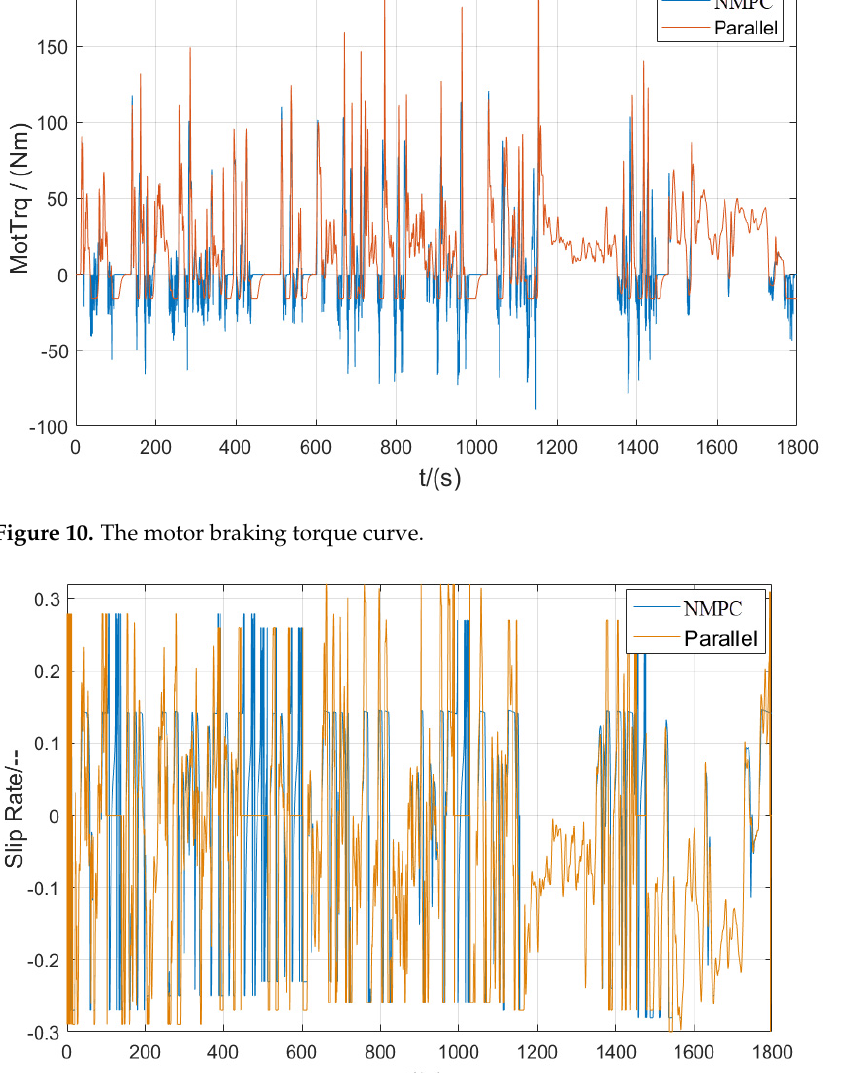
Figure 9. The battery SOC curve.